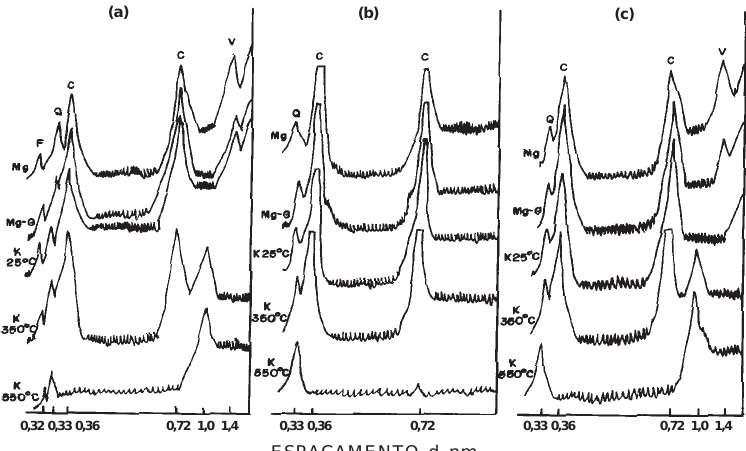
Figura 2. Difratogramas de raios-X da fração argila orientada dos tratamentos com K e aquecimento (K 25, 350 e 550 o C), magnésio (Mg) e magnésio + etileno glicol (Mg + G) dos horizontes do perfil de Solonetz Solodizado: (a) horizonte A; (b) horizonte 2Btn e (c) horizonte 2CB. (C = caulinita; V = vermiculita e Q =